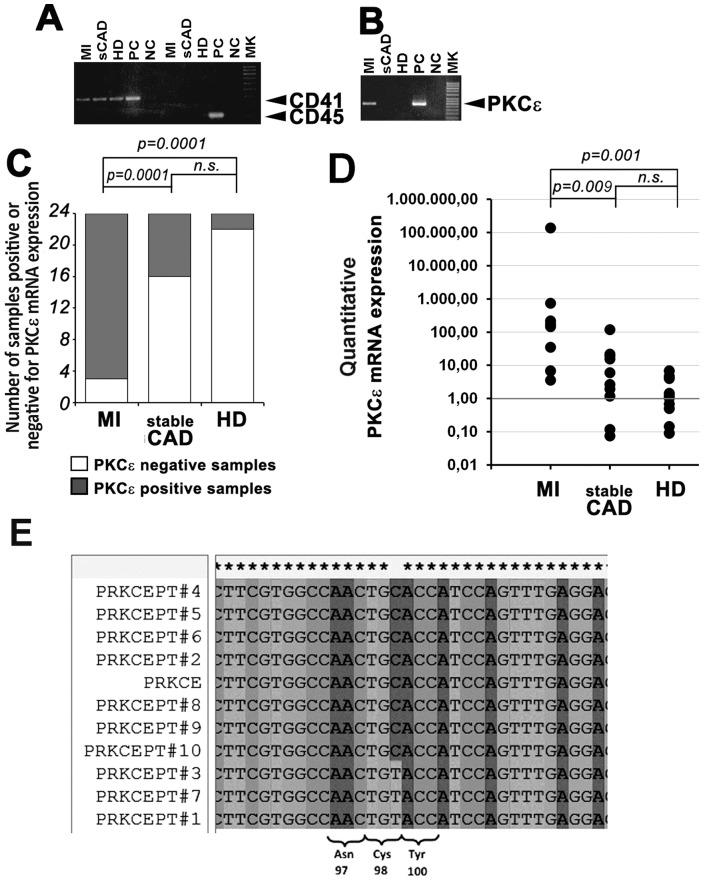
Platelets from MI patients contain mRNA for PKCε.
Panel A: Representative RT-PCR analysis of CD41 and CD45 expression in MI, sCAD and healthy donor platelets. Equal amounts of total cDNA were amplified by PCR to detect the indicated mRNA expression. CD45 is not expressed in isolated platelets, indicating the absence of nucleated cell contaminants. Panel B: Representative RT-PCR analysis of PKCε expression in MI, sCAD and healthy donor platelets. Equal amounts of total cDNA were amplified by PCR to detect PKCε mRNA. Platelets from MI patients express PKCε. PC: positive control; NC: negative control. Panel C: Analysis of PKCε RNA expression in MI, sCAD and HD platelets. The samples positive to PKCε mRNA expression in MI, sCAD and HD were respectively 21, 8, 3 out of 72 (24 each group) (Chi-square test: p = 0.0001 MI vs HD; p = 0.0001 MI vs sCAD; no significant differences were found between sCAD and HD). Panel D: Quantitative analysis of PKCε mRNA expression by real-time PCR. Equal amounts of total cDNA were amplified by PCR. The expression level of PKCε mRNA in each patient was compared with the mean expression in the HD group. Data from 10 patients of each group are shown (Mann Whitney test: p = 0.001 MI vs HD; p = 0.009 MI vs sCAD; no significant differences were found between sCAD and HD). Panel E: PKCε sequencing in MI patients. The presence of PKCε was further confirmed in MI patients by bi-directional sequencing. Representative fragment of the cDNA sequences (reverse strand) of PKCε encompassing the exons 1 and 2 (from nucleotide 11 to nucleotide 397). Patients #1, #3 and #7 belonging to the MI group showed the presence (in heterozygosity) of the rs12615152 (c.294C>T, p.Cys98Cys).